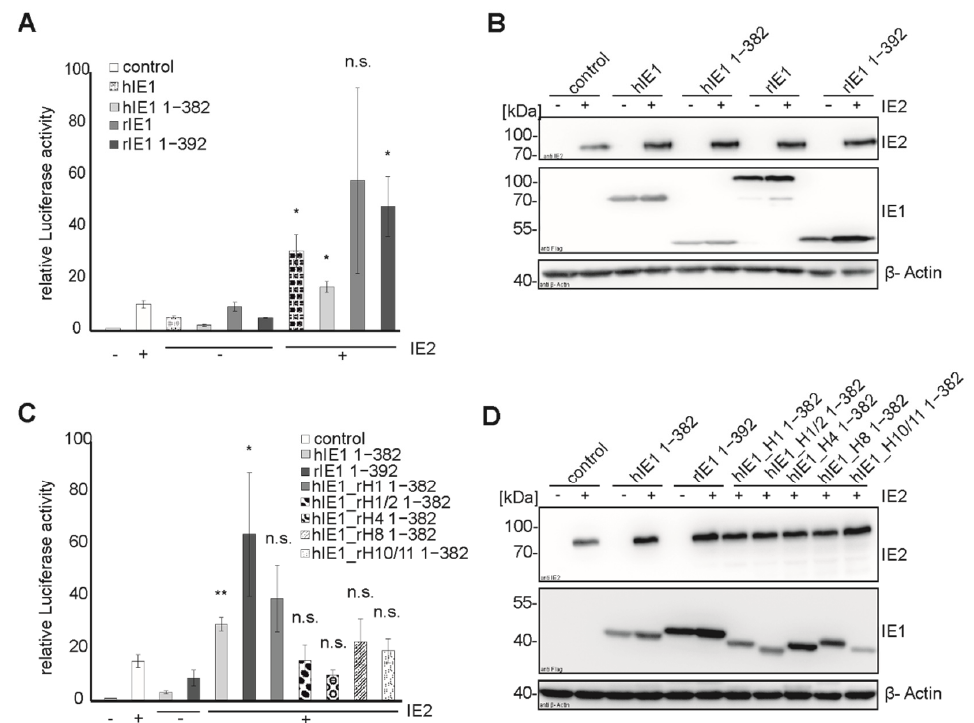
Figure 6. Activation of the HCMV UL112 promoter by rIE1 and hIE1_rH mutants. HEK293T cells were transfected with IE2 and IE1 in different combinations. In all samples, a plasmid encoding the firefly luciferase under control of the HCMV UL112 promoter was cotransfected. 24 h after transfection, the luciferase activity assay was performed. ( A , C ) Luciferase assay of IE1 homologs, their core version, and hIE1_rH mutants either alone or in combination with IE2. The transactivation activity of IE1 homologs is represented by mean values ± SD of three independent experiments. Statistical significances of transactivation by IE1 homologs and IE1_rH mutants compared to control were calculated using the Student t -test and are indicated by asterisks: * p < 0.05; ** p < 0.01; n.s. = non-significant. ( B , D ) The expression of proteins was controlled by Western blot analyses. The proteins were stained with mAB Flag, pAB IE2, and mAB β -actin.